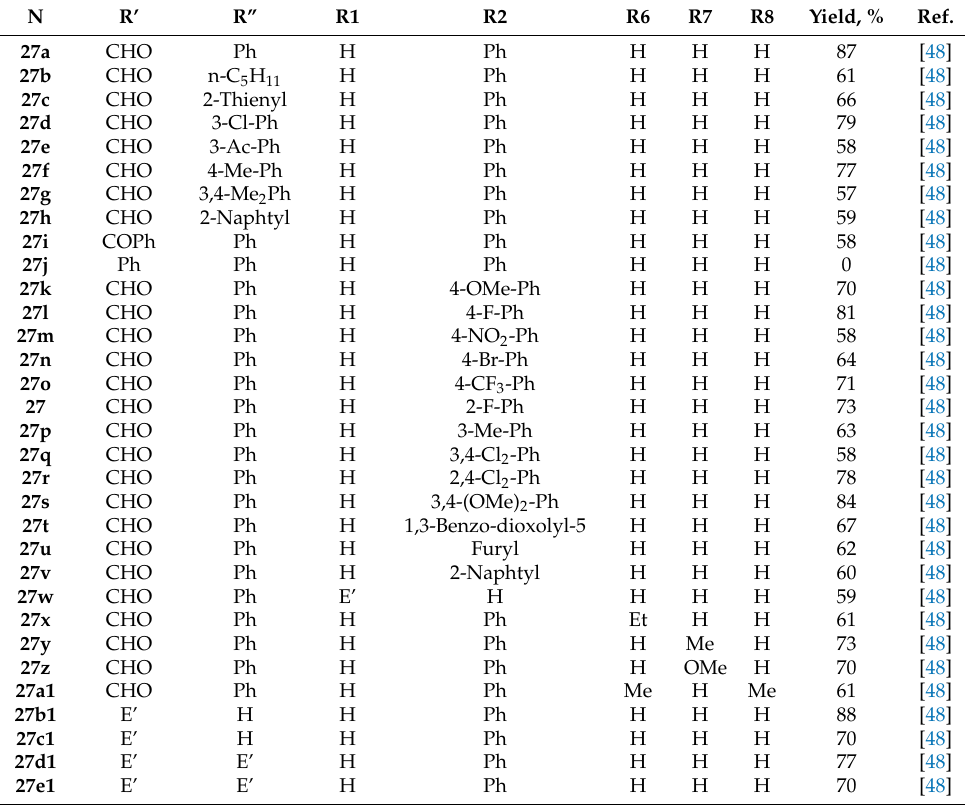
Table 4. Substituents and yields of photochemical cycloaddition to indolizines (Scheme 11).